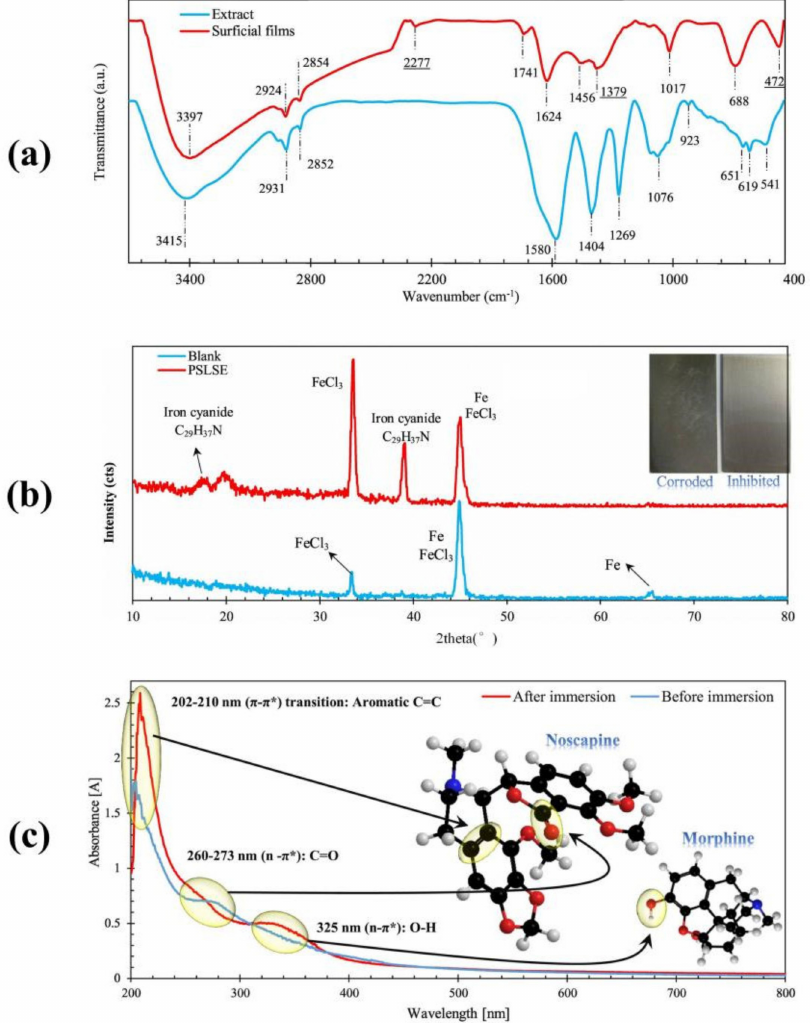
Figure 12. ( a ) FTIR spectra of the extract powder and the surficial film formed on the inhibited steel surface, ( b ) XRD patterns for the steel samples immersed in 1.0 M HCl solution in the presence and absence of PSLSE, ( c ) UV–Vis spectra before and after immersing the steel samples into 1.0 M HCl solution in the presence of PSLSE for 2.5 h. (Reprinted with permission from Ref. [215].